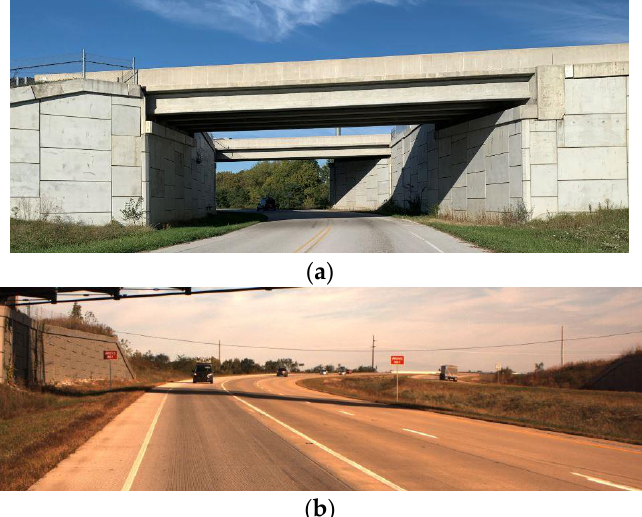
Figure 4. Two types of MSE walls: ( a ) Multi-face planar MSE wall and ( b ) Curved MSE wall with piece-wise planar façade.